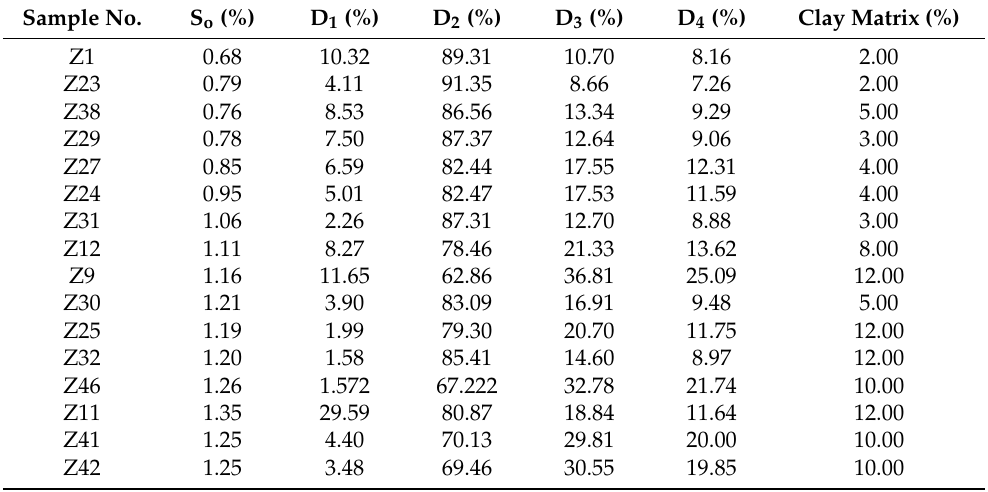
Table A4. The content of clay matrix, the sorting coefficients and grain sizes of deep-mine sand-stone. Sample